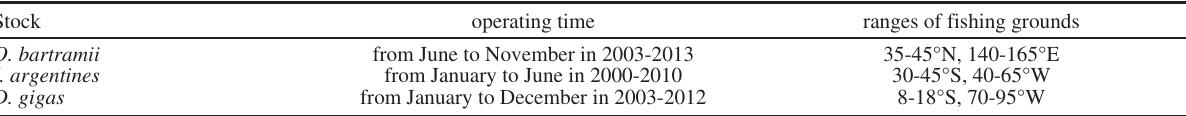
Table 1. – The spatial and temporal range of Chinese squid-jigging fishery for O. bartramii in the Northwest Pacific, I. argentinus in the Southwest Atlantic and D. gigas in the southeast Pacific. Stock ranges of fishing